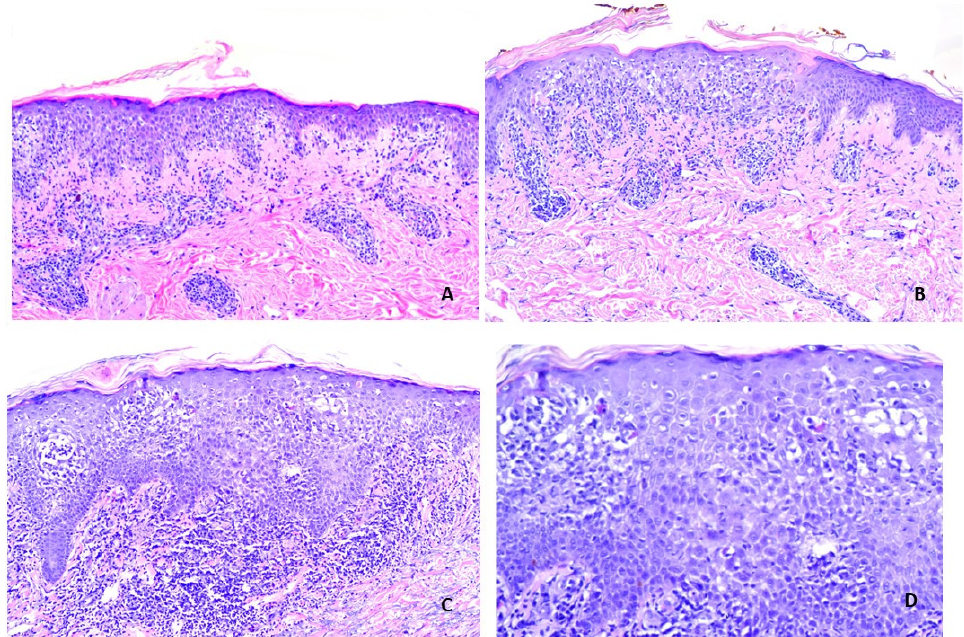
Figure 5. V-ILEs, Cases 1 and 6. These cases showed atypical features in an otherwise lichenoid eruption. ( A , B ) V-ILE Case 1. Each of two biopsies showed a poorly defined lichenoid infiltrate with spongiosis. (Hematoxylin-eosin stain; Original magnification, × 100). ( C , D ) V-ILE Case 6B, second biopsy. There is a poorly defined lichenoid infiltrate and necrotic keratinocytes at all levels of the epidermis associated with spongiosis. ( C , D ) Hematoxylin-eosin stain; Original magnification, × 100 ×